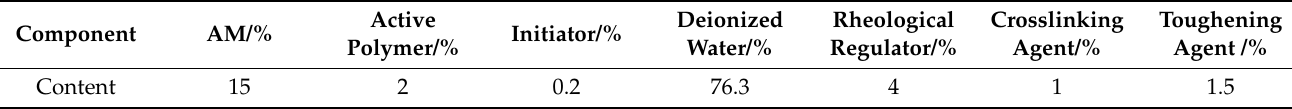
Table 3. Component content of the